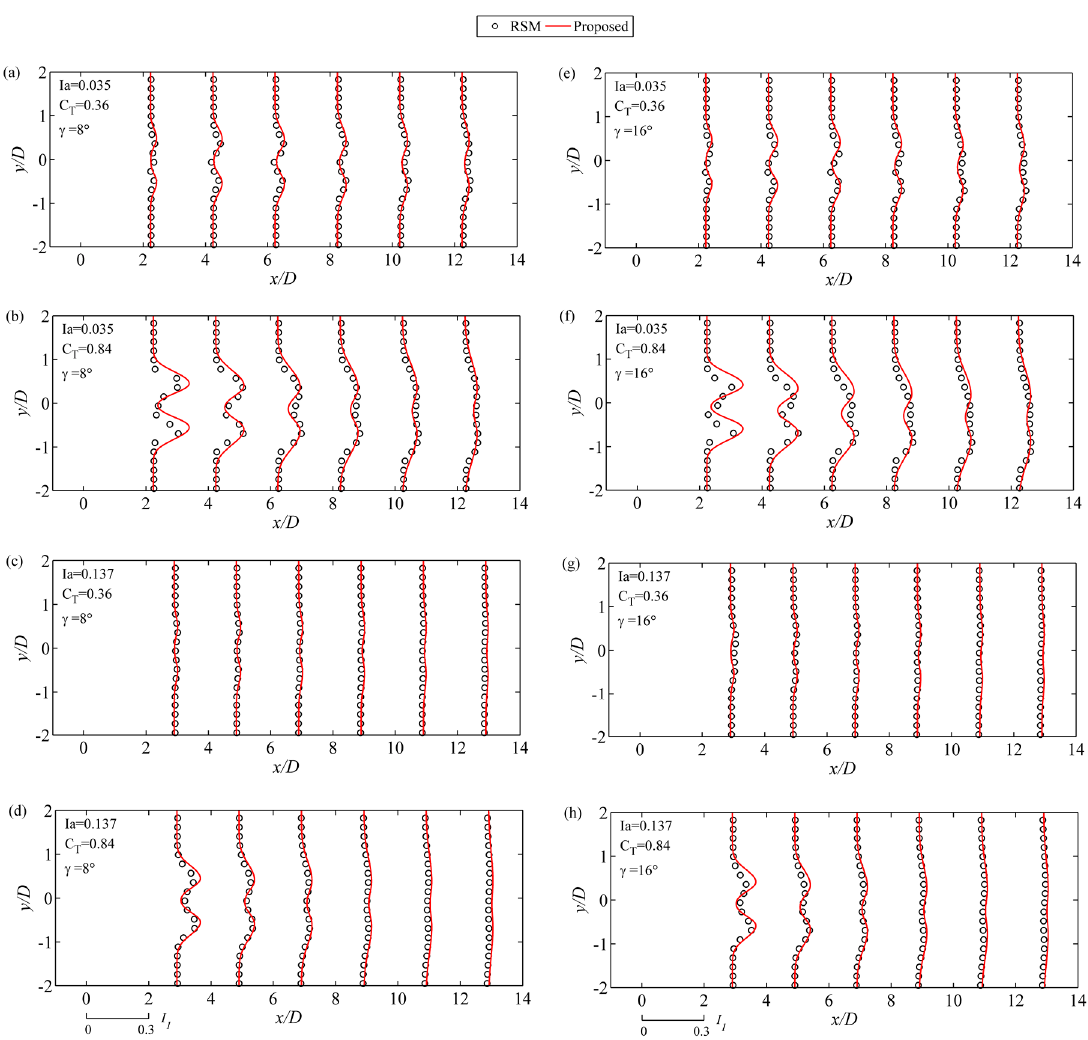
Figure 13. Validation for the predicted turbulence intensity in the yawed conditions.